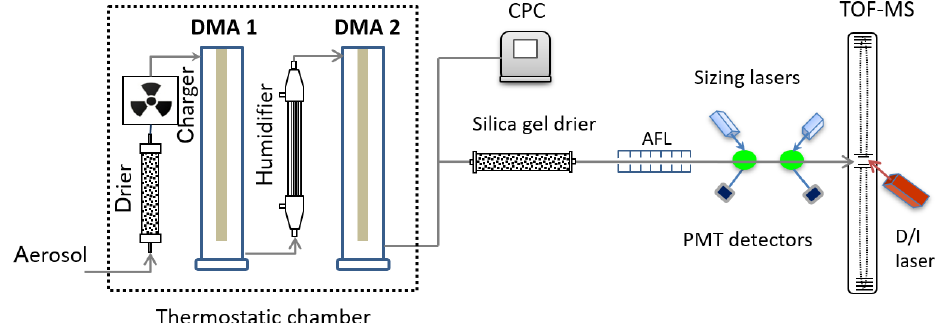
Figure 1. The schematic of HTDMA–ATOFMS characterization setup showing the major parts of the HTDMA (left) and ATOFMS (right). The humidifier in the HTDMA was maintained at 85%